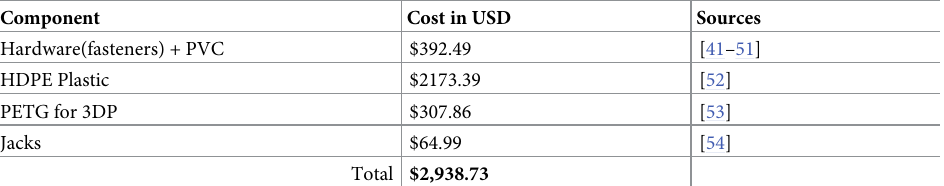
Table 4. Overall costs (2022 values).